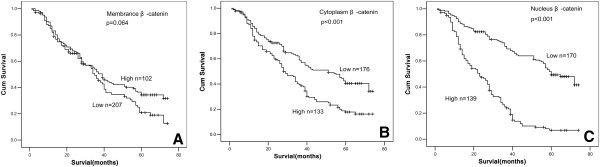
The Kaplan-Meier analysis of survival rate of patients according to status of β-catenin expression. The influence of membranous (A), cytoplasmic (B), and nuclear (C) β-catenin expression on the prognosis of patients with NSCLC is shown.